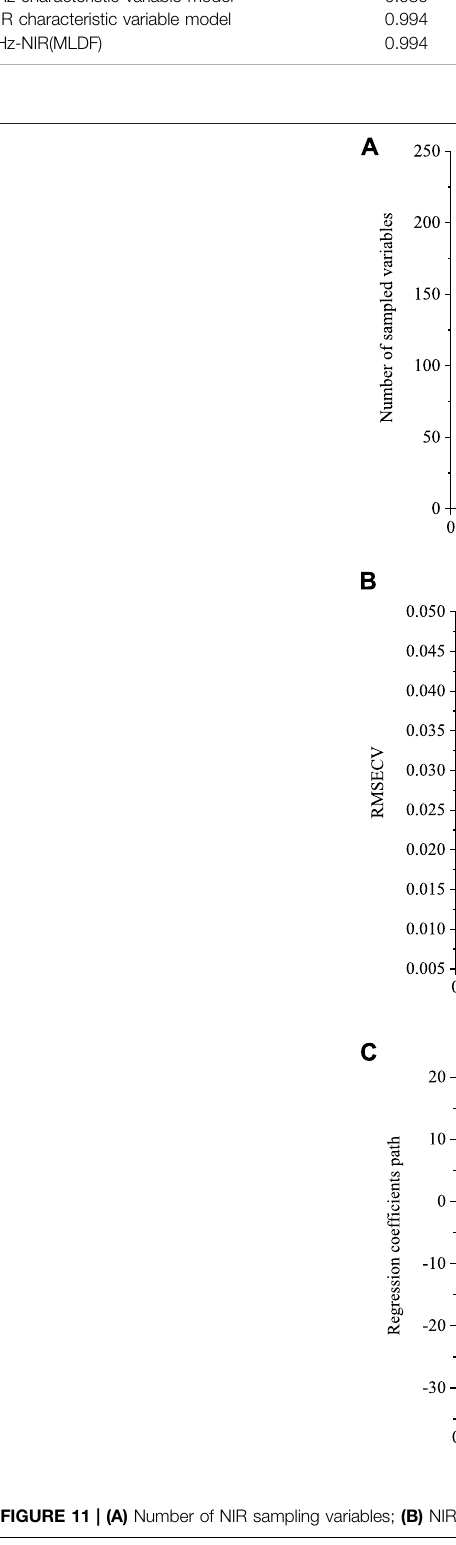
Frontiers in Physics |